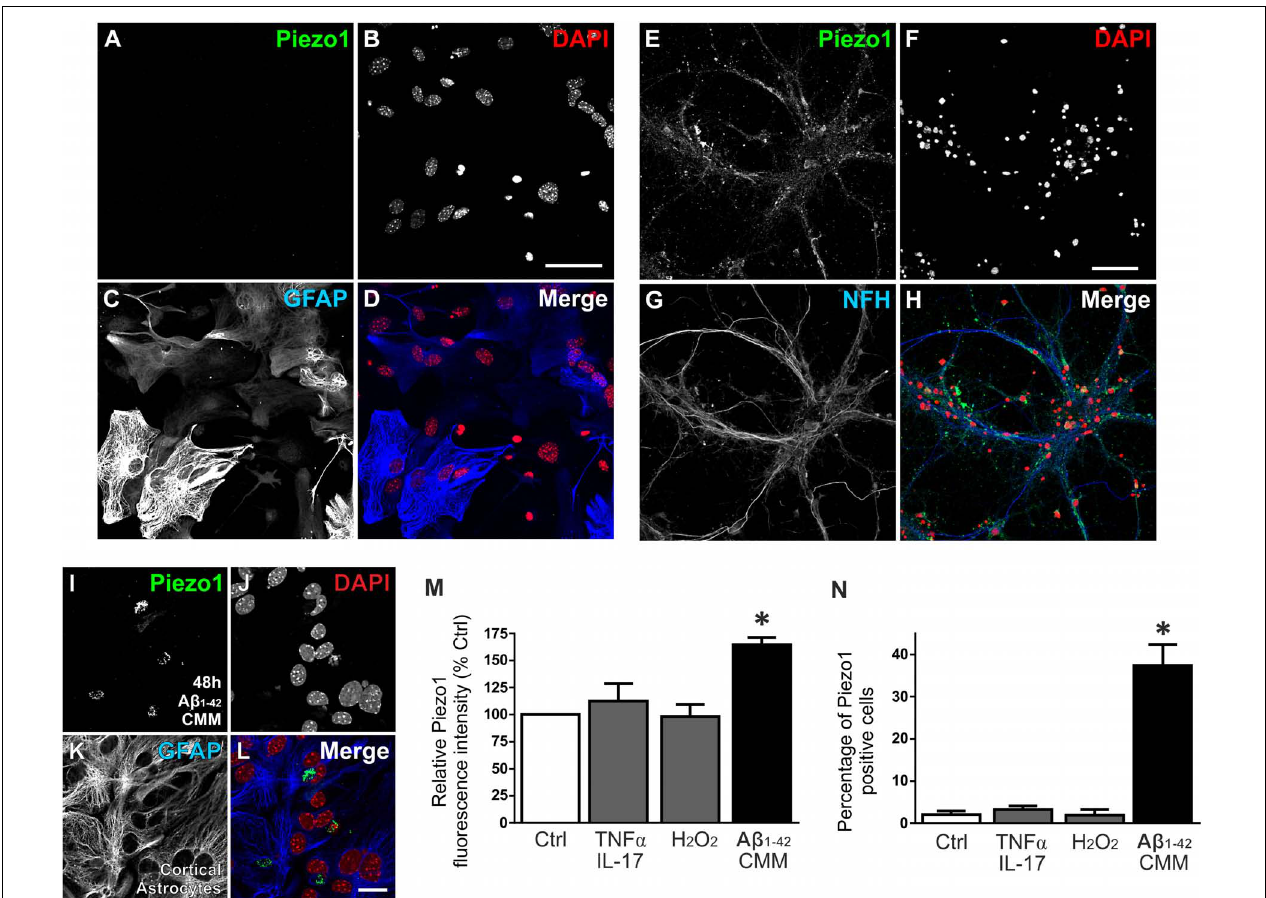
FIGURE 3 | A β 1 − 42 CMM upregulates Piezo1 expression in cortical astrocyte cultures. To check cellular localisation of Piezo1 in the brain, enriched astrocyte cultures (A–D) and cortical neuronal cultures (E–H) from newborn mice were stained for (A,E) Piezo1 (N-terminal antibody) and (C) GFAP or (G) neurofilament H (NFH), respectively ( n = 3). Piezo1 co-localized with NFH staining in neurons (H) but was almost completely absent from astrocytes under basal conditions (D) . To investigate if neuroinflammatory stimuli can induce Piezo1 expression in astrocytes, mouse microglia were exposed to human A β 1 − 42 (Invitrogen, United Kingdom) for 24 h and the inflammatory media was collected. Enriched mouse astrocyte cultures were then exposed to this A β 1 − 42 CMM for 48 h. Astrocytes were immunofluorescently stained for (I) Piezo1 (C-terminus antibody), (J) DAPI, (K) GFAP, and (L) is the merge of each channel. Scale bar = 20 µ m. Exposure to A β 1 − 42 CMM upregulated Piezo1 protein expression in approximately 30–40% of astrocytes (M,N) . Astrocytes were also treated for 24 h with either 5 µ M hydrogen peroxide (H 2 O 2 ) or a cytokine cocktail consisting of TNF- α (10 ng/mL) and IL17A (250 ng/mL). Neither H 2 O 2 nor TNF- α /IL17A increased Piezo1 expression indicating that Piezo1 upregulation is not a common response to all cell stressors but specific to certain inflammatory stimuli including A β 1 − 42 and factors released by reactive amyloid-stimulated microglia. Data are represented as mean ± SEM ( n = 8). A repeated measures one-way ANOVA with Holm-Sidak post hoc test was performed. ∗ Represents a statistically significant difference ( p < 0.05) from control (Ctrl), TNF- α /IL17A, and H 2 O 2 treatment